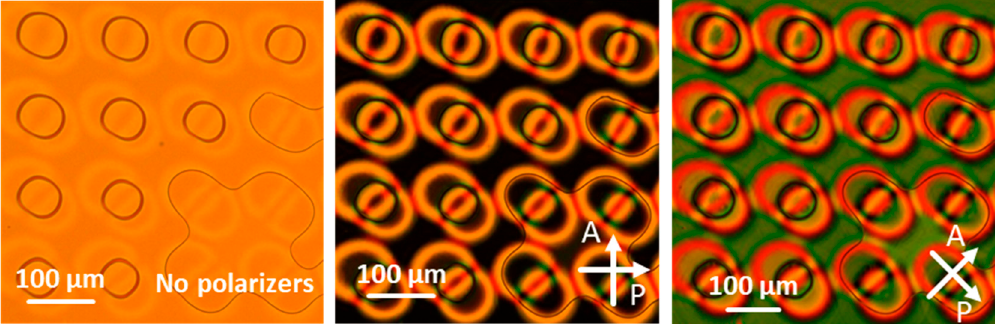
Figure 4. Microscope images of the cell (0V) in a region where the centra of the patterned rings at the top and bottom substrate are substantially shifted. The dimensions of the patterned rings are r out = 50 µm (r in = 0.4 * r out ). The transmission is show without polarizers present (left), between crossed polarizers aligned with x- and y-axis (middle) and for crossed polarizers rotated over 45 ž° with respect to the x- and y-axis (right).